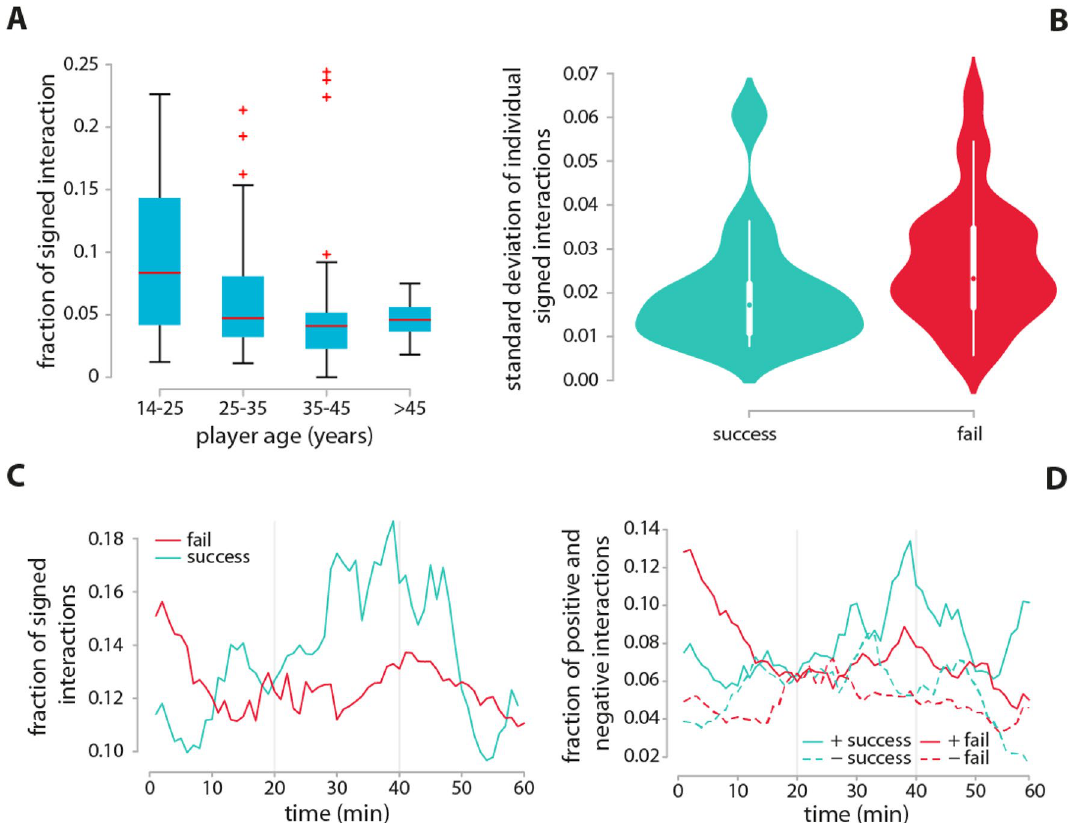
Figure 4. Signed interactions. Older players initiate less signed communication than younger members ( A ), suggesting a greater focus on task performance. While the total amount of emotionally charged interactions is similar in successful and failed teams, successful groups are more emotionally balanced across their individuals than the failed ones. This is quantified by the standard deviations of signed interactions across team members ( B ). Failed teams are characterized by a greater frequency of positive interactions in the initial stage of the game, which however rapidly declines over time ( C ). This trend is largely due to the high initial frequency of positive ties ( D ), possibly suggesting a lower amount of task focus. Surprisingly, successful teams show a slightly higher rate of negative interactions, suggesting that a minimum level of tense communication might be beneficial for collective problem